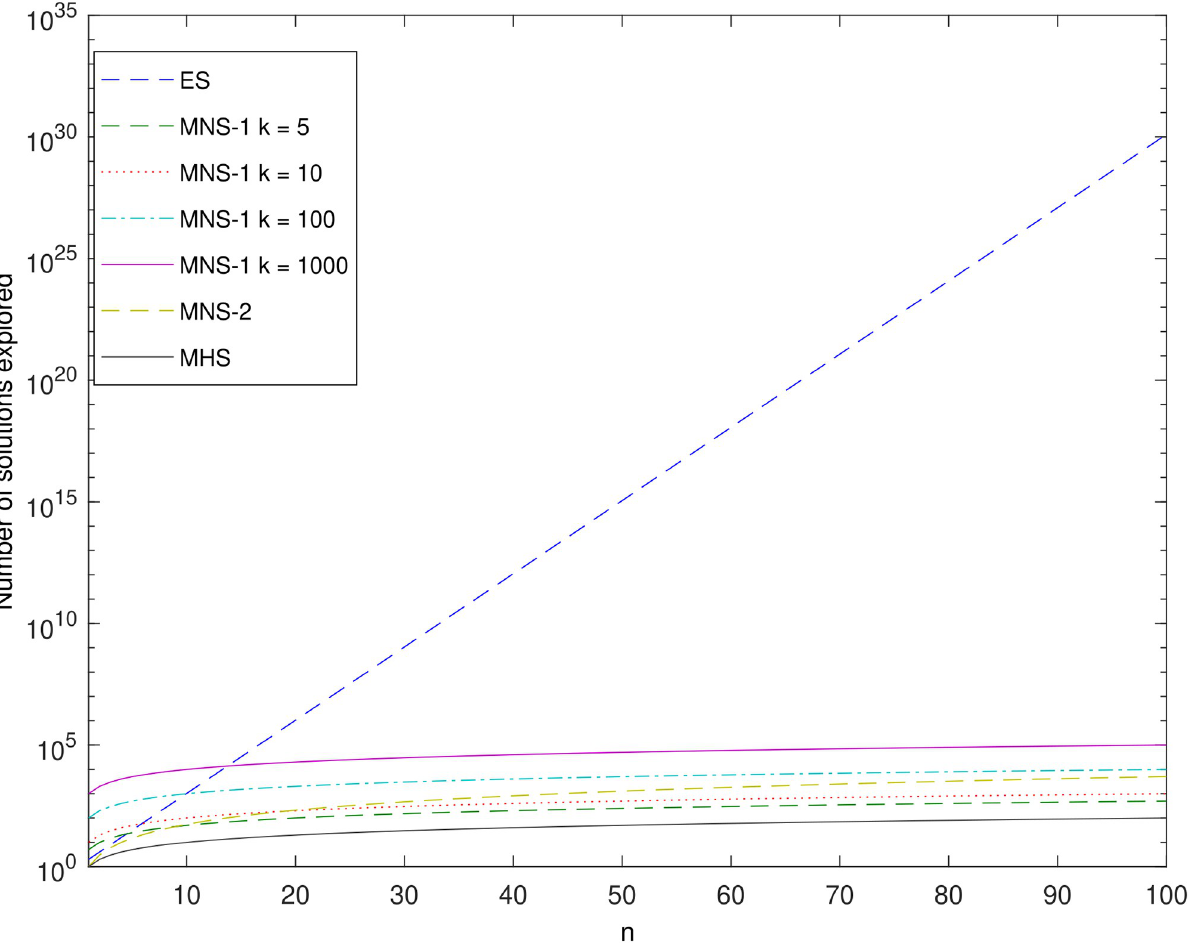
Fig 5. Complexity comparison between ES and SBS